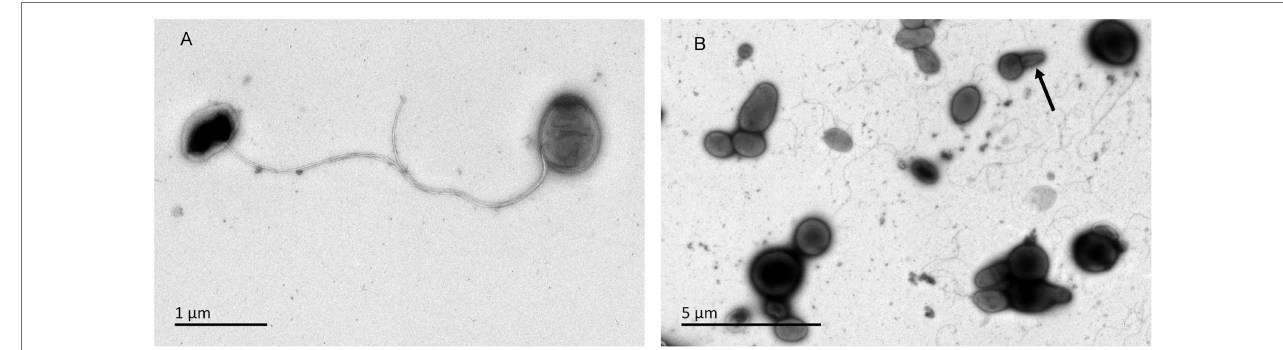
FIGURE 5 | Transmission electron micrograph of strain CPCC 205119 T grown on GYM semi-solid medium (0.3% agar) for 7 days at 28 ° C. Bar, 2 μ m. (A) Showing the flagella; (B) arrow, indicating the bud-like